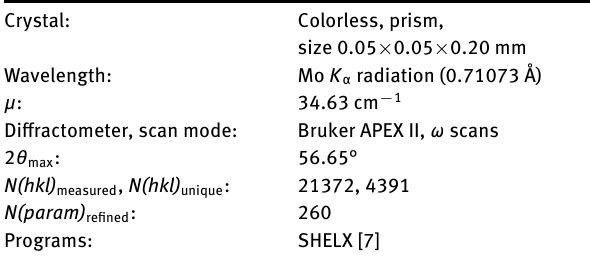
Table 1: Data collection and handling.